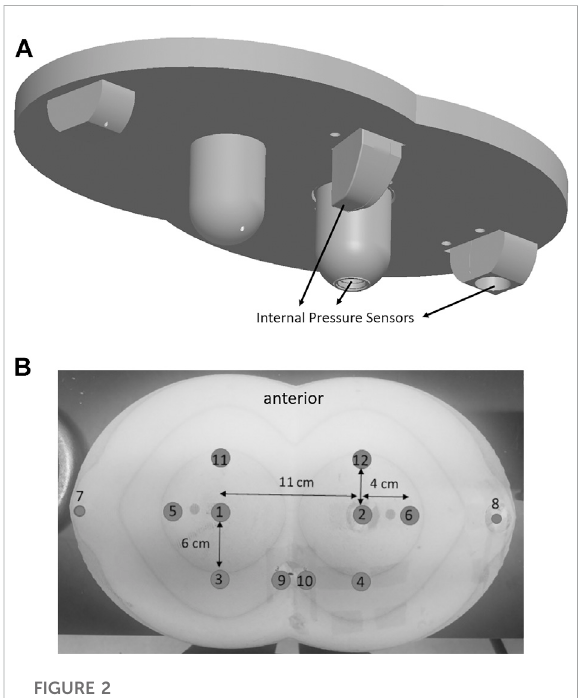
FIGURE 2 (A) Rigid substructure, internal pressure sensor locations and (B) surface sensor locations depicted on the trigonometric model.